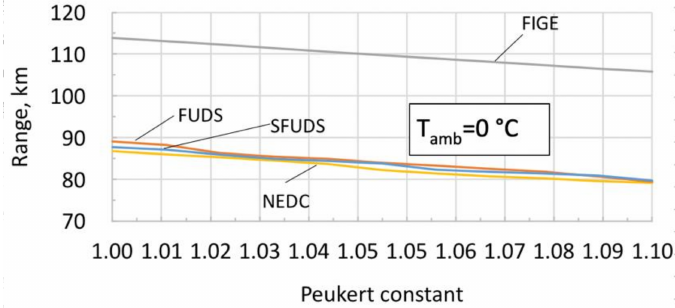
Figure 5. Driven range as function of the Peukert constant k in the case of ambient temperature of 0 ◦ C.